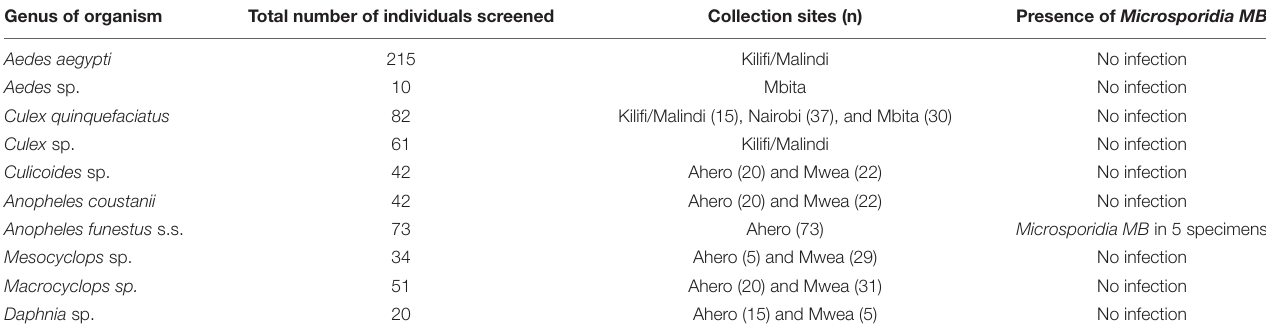
TABLE 6 | Microsporidia MB was not observed in non-anopheline arthropods from the same habitats as An. arabiensis . Genus of organism Total number of individuals screened Collection sites (n) Presence of Microsporidia